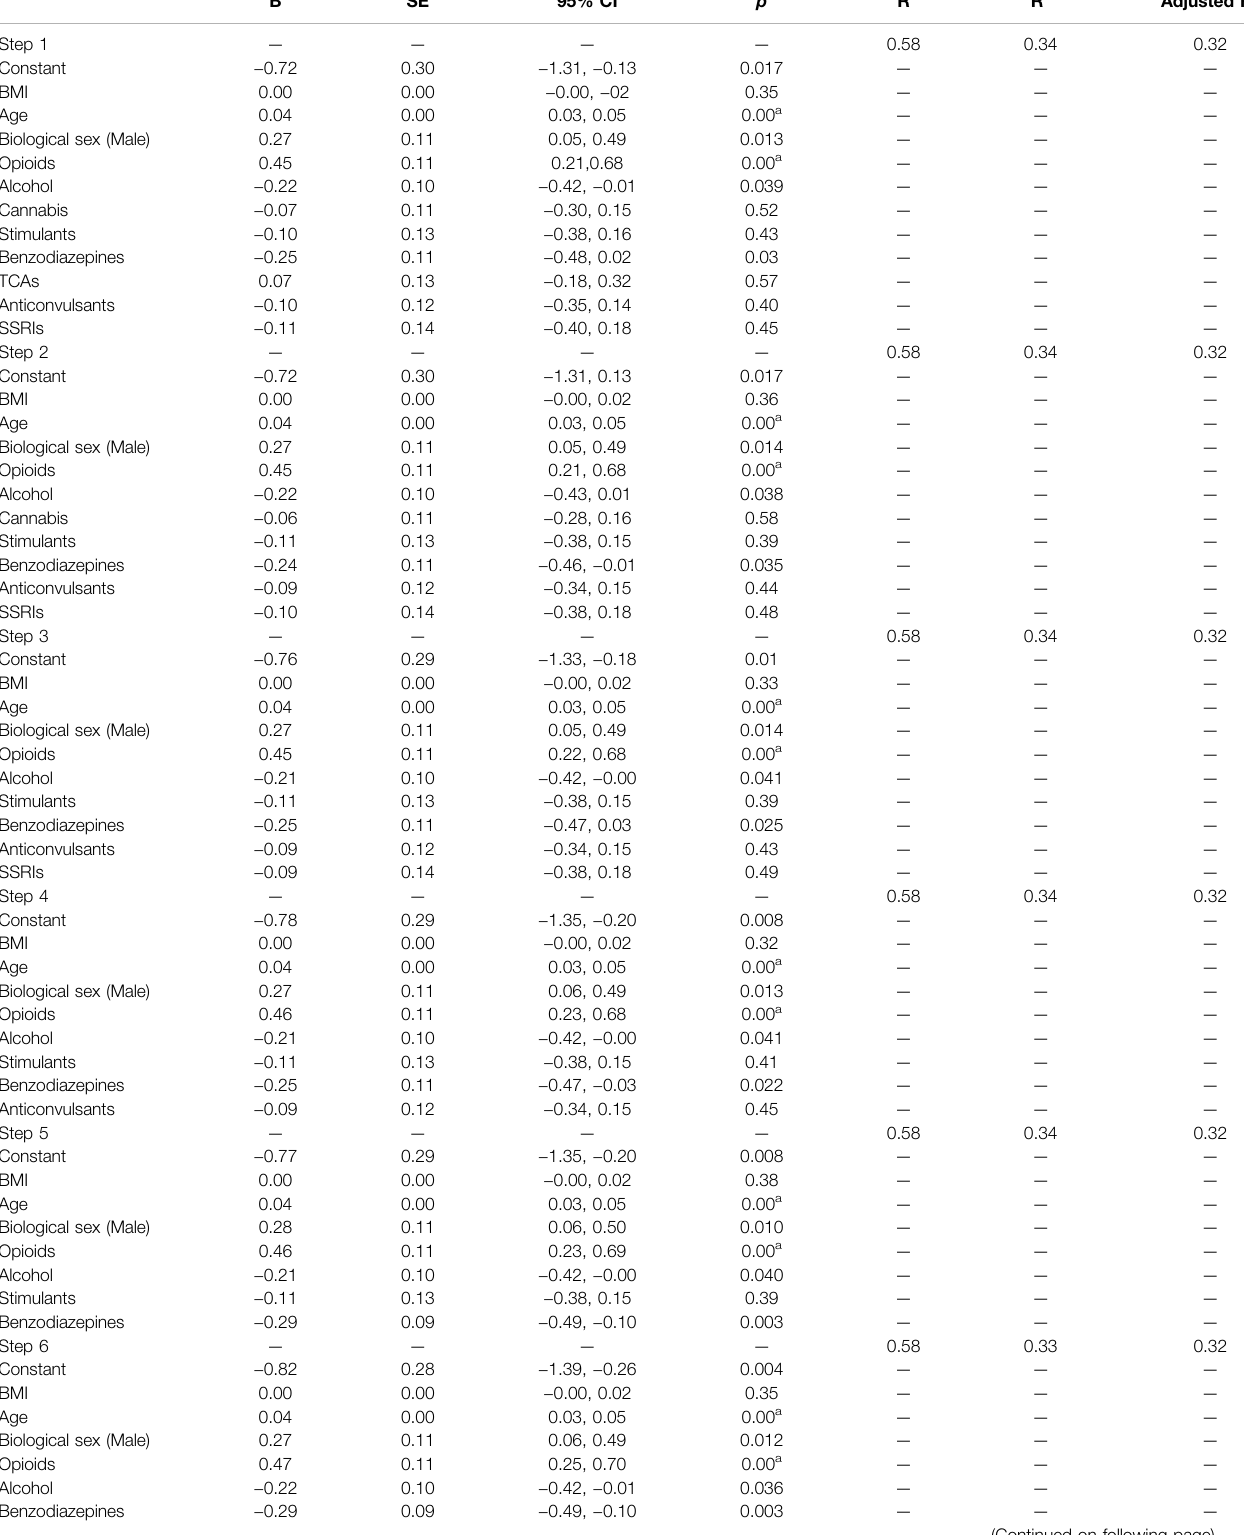
TABLE 4 | Stepwise multiple regression model with backward procedure predicting total cardiovascular disease (CVD) severity from age, BMI, sex, opioids, alcohol, cannabis, stimulants, benzodiazepines, TCAs, anticonvulsants, and SSRIs in 436 post-mortem